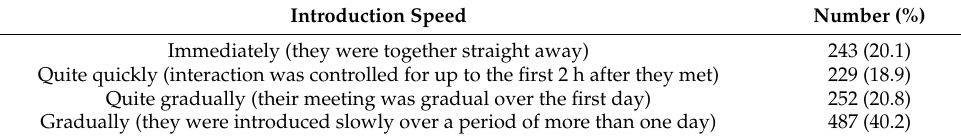
Table 3. Owner-reported introduction speed of 1211 puppies to existing household cat(s).